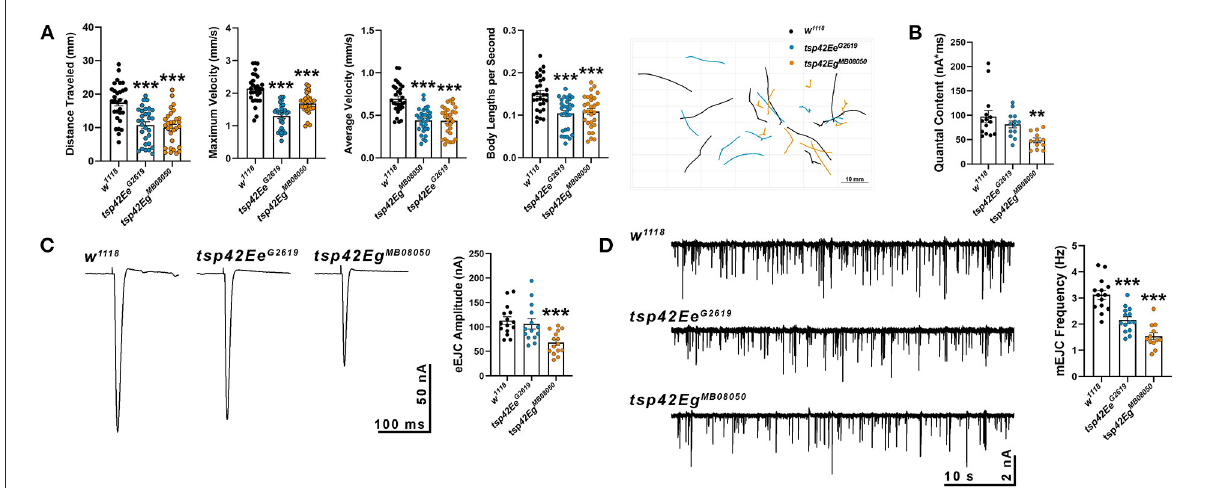
FIGURE2 Tetraspanin function is important for proper vesicle release and locomotion. (A) wrMTrck quantification of larval crawling behavior on an agar arena for 30s. Distance traveled, maximum velocity, average velocity, and crawling velocity normalized to body size (body lengths per second) were significantly reduced in both tsp42Ee ( p < 0.0001) and tsp42Eg mutants ( p < 0.0001). (B) Quantal content is significantly reduced in tsp42Eg MB 08050 ( p = 0.0022) but not tsp42Ee G 2619 ( p = 0.28) mutants. (C) Representative traces (left) and quantification (right) show reduced eEJC amplitudes in tsp42Eg MB 08050 ( p < 0.0001) but not tsp42Ee G 2619 ( p = 0.60) mutants. (D) Representative mEJC traces (left) from larval body wall muscle 6. Quantification (right) of mEJC frequency indicates both tsp42Ee G 2619 ( p = 0.0001) and tsp42Eg MB 08050 ( p < 0.0001) mutants exhibit significant reductions in mEJC frequency. Error bars represent SEM. Unpaired t tests were used for all statistical